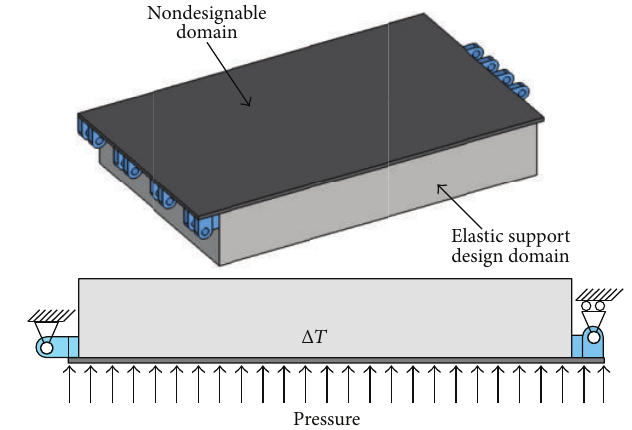
Figure 7: Nozzle flap model and its design domain, loads, and boundary conditions.